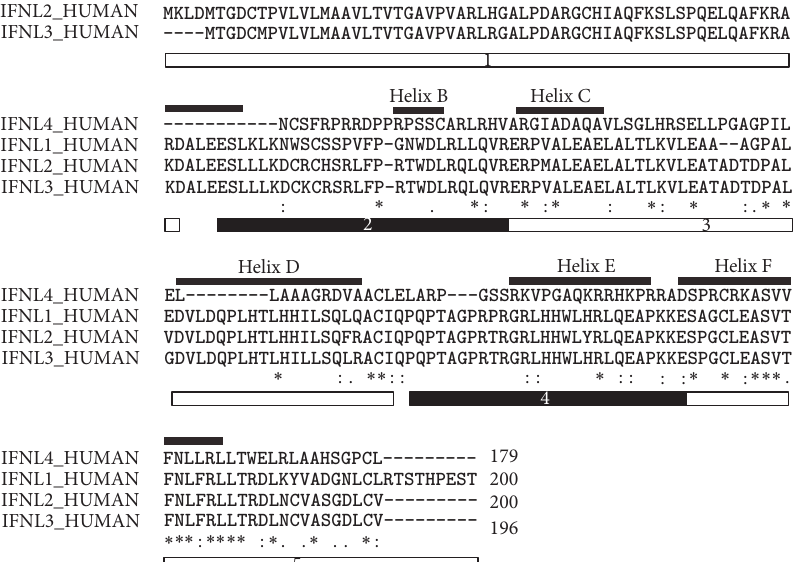
Figure 1: Sequence alignment and amino acid conservation of IFNLs. Clustal Omega (1.2.3) alignment [37] of IFNL proteins (IDs: Q8IU54, Q8IZJ0, Q8IZI9, and K9M1U5). Exons are indicated by the black and white boxes below the sequences. Positions of helices are indicated by the lines above the sequences. Identical amino acids are marked by an asterisk ( ∗ ); conserved amino acids by a colon (:); and semiconserved amino acids by a period (.).